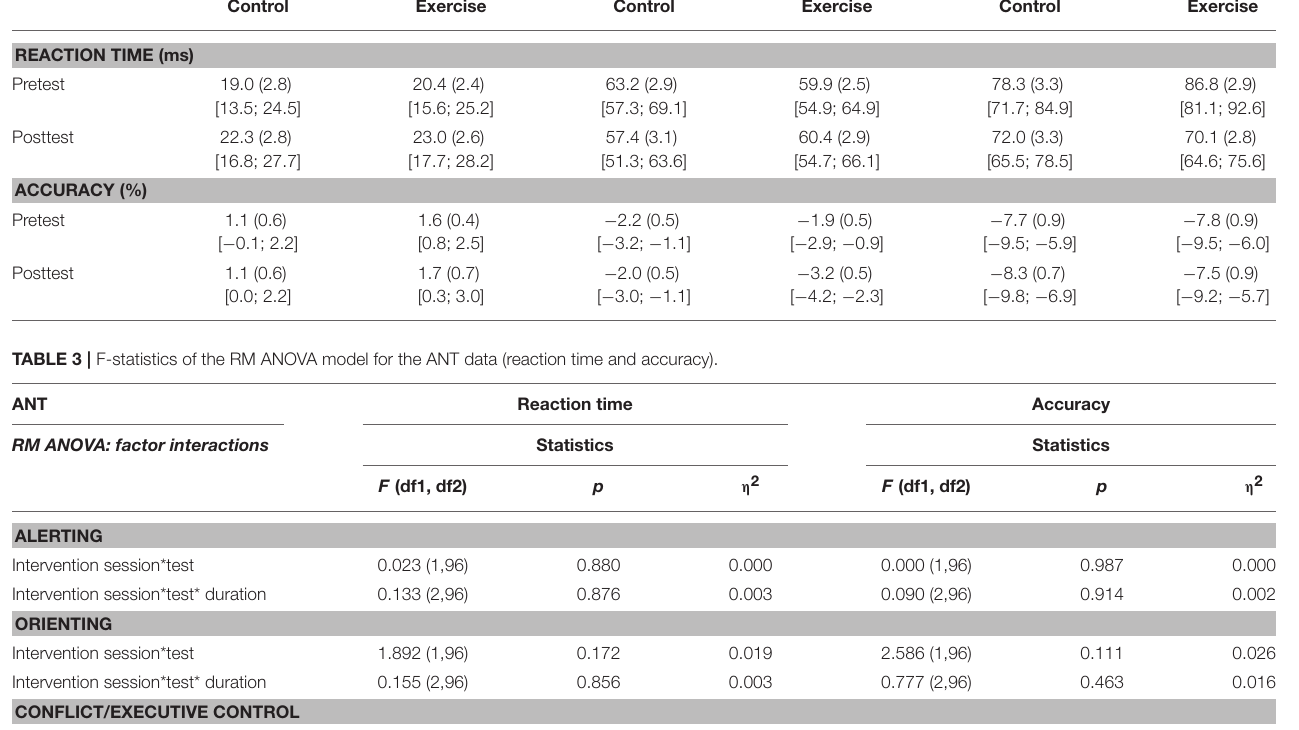
TABLE 2 | ANT data: pre- and posttest scores in the control and exercise condition (means, standard errors and 95% confidence intervals). Alerting